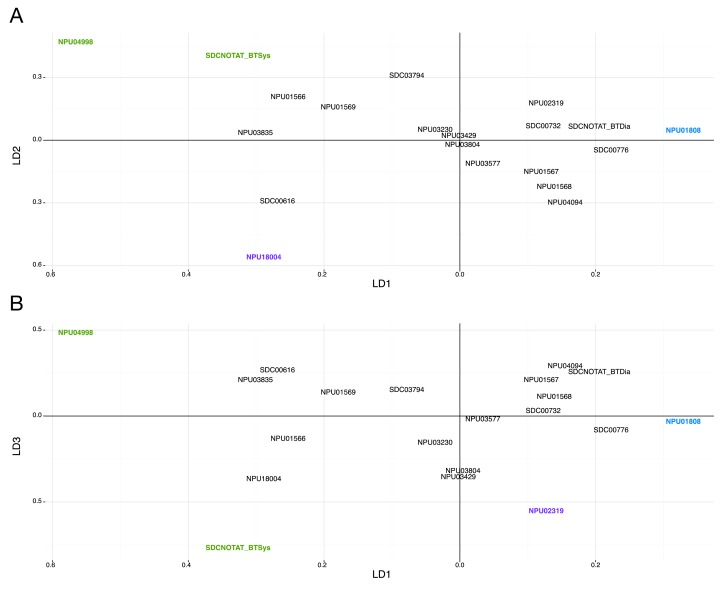
Linear Discriminant Analysis 1 (LDA).Linear Discriminant Analysis (LDA) was performed on the biochemical tests for the 71 clusters with at least 50 individuals. The linear discriminants (LD) 1 and 2 (A) and 1 and 3 (B) for the LDA, are shown using the biochemical test identifiers. Identifiers in blue contributes most to the variance among clusters for LD1, purple identifiers contribute most to the variance from LD2 or LD3, and green colored identifiers are common across LD1 and LD2 or LD1 and LD3.